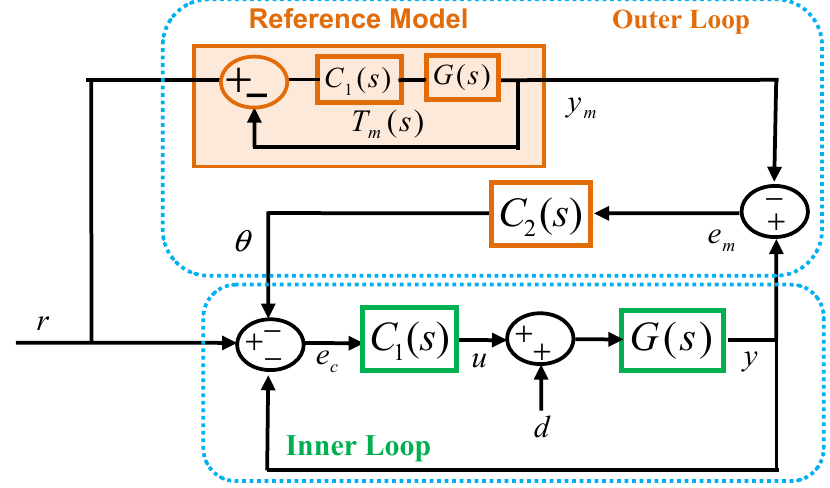
Figure 12. Block diagram of the ML-MR PID-IM control structure.